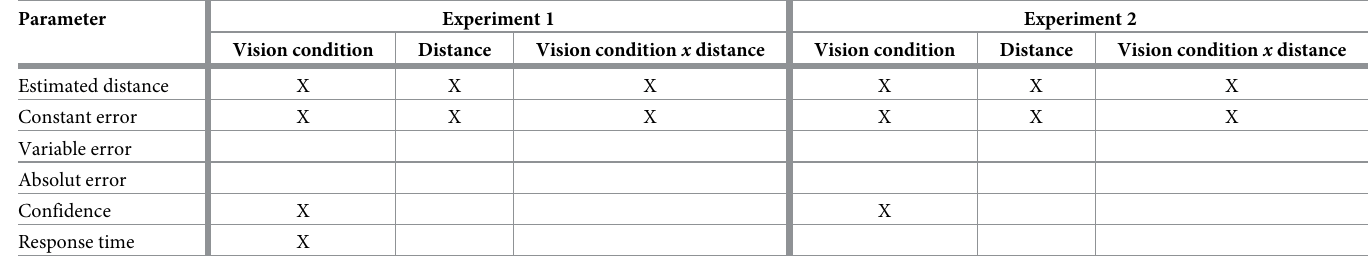
Table 21. Overview of significant differences in experiment 1 and